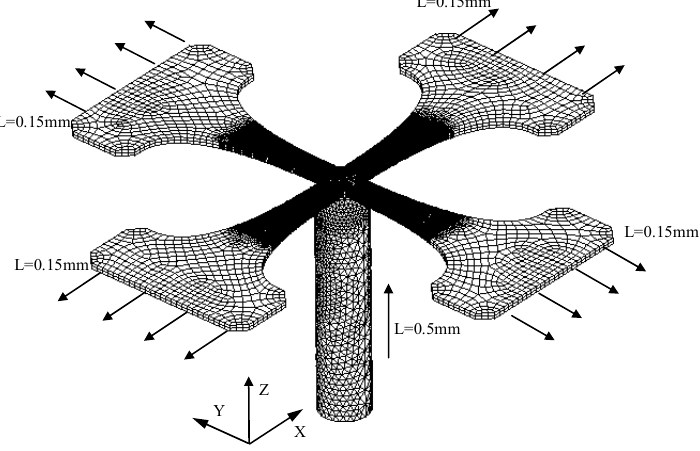
Figure 6. Finite element simulation model. Table 1. Mechanical properties of the test specimen material